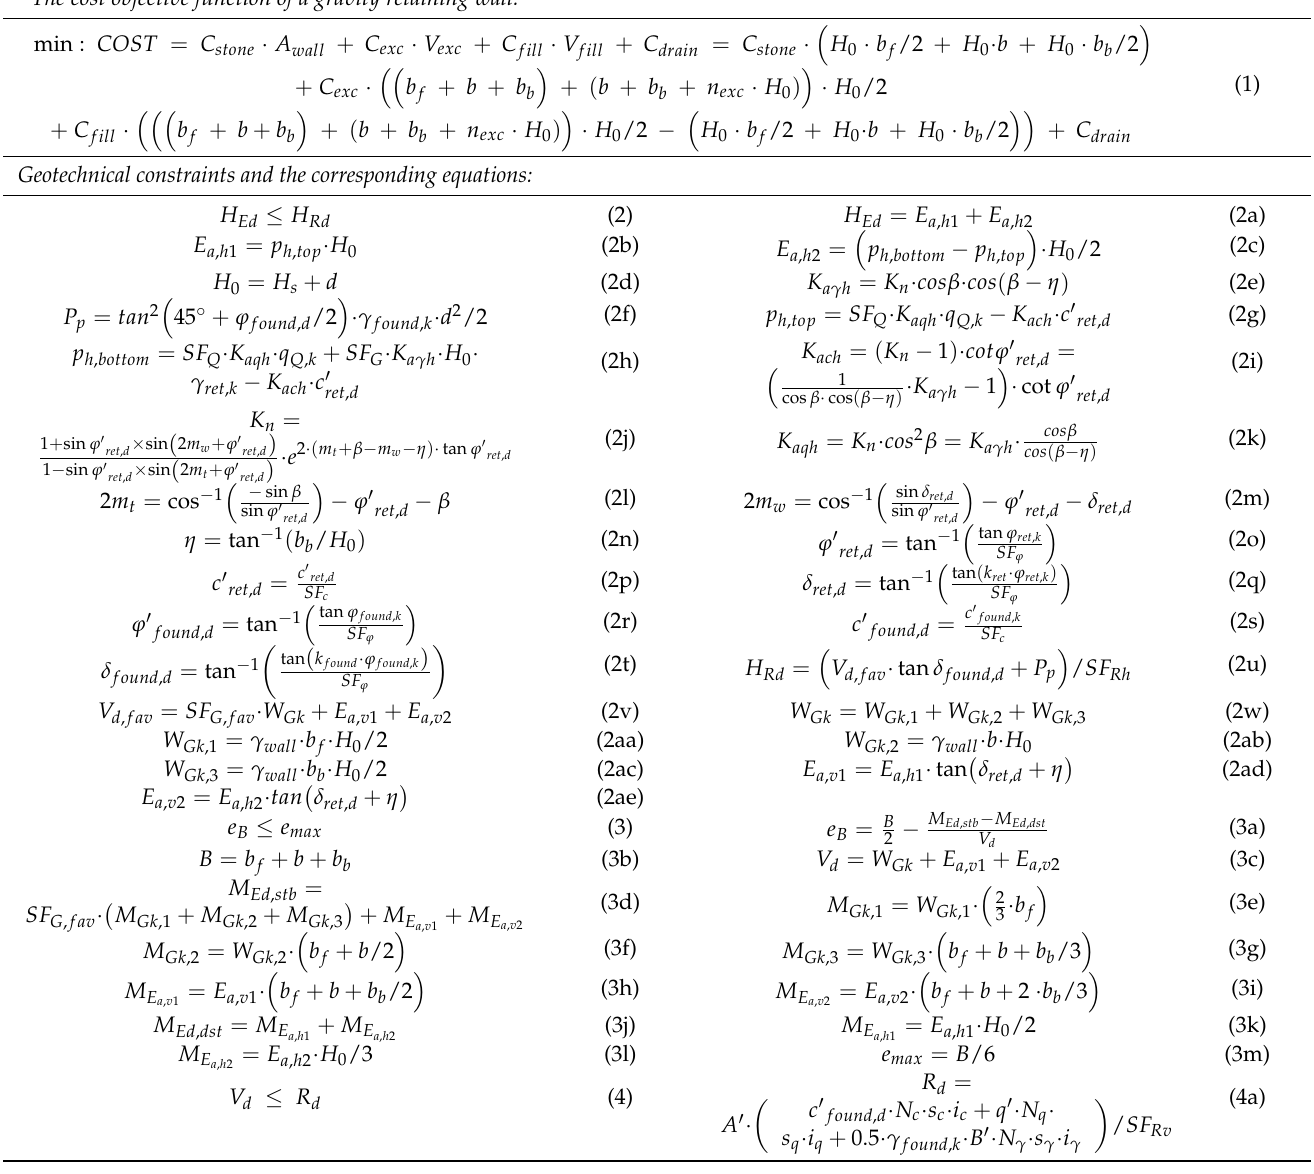
Table 1. Optimization model for an